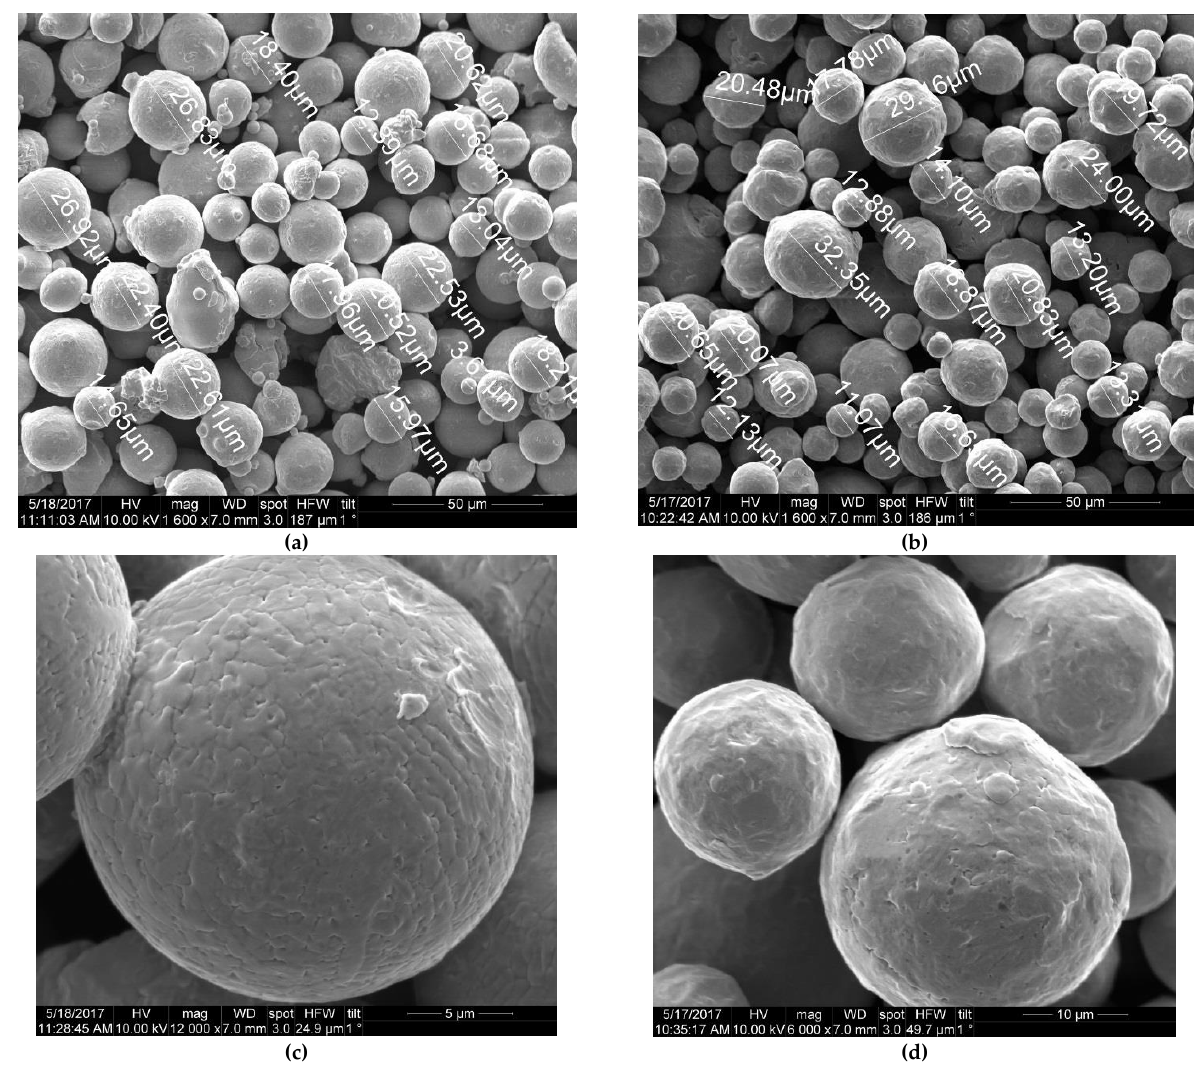
Figure 1. SEM image of Inconel 718 alloy ( a , c ) and 316L austenitic steel ( b , d ) powders at different magnifications.